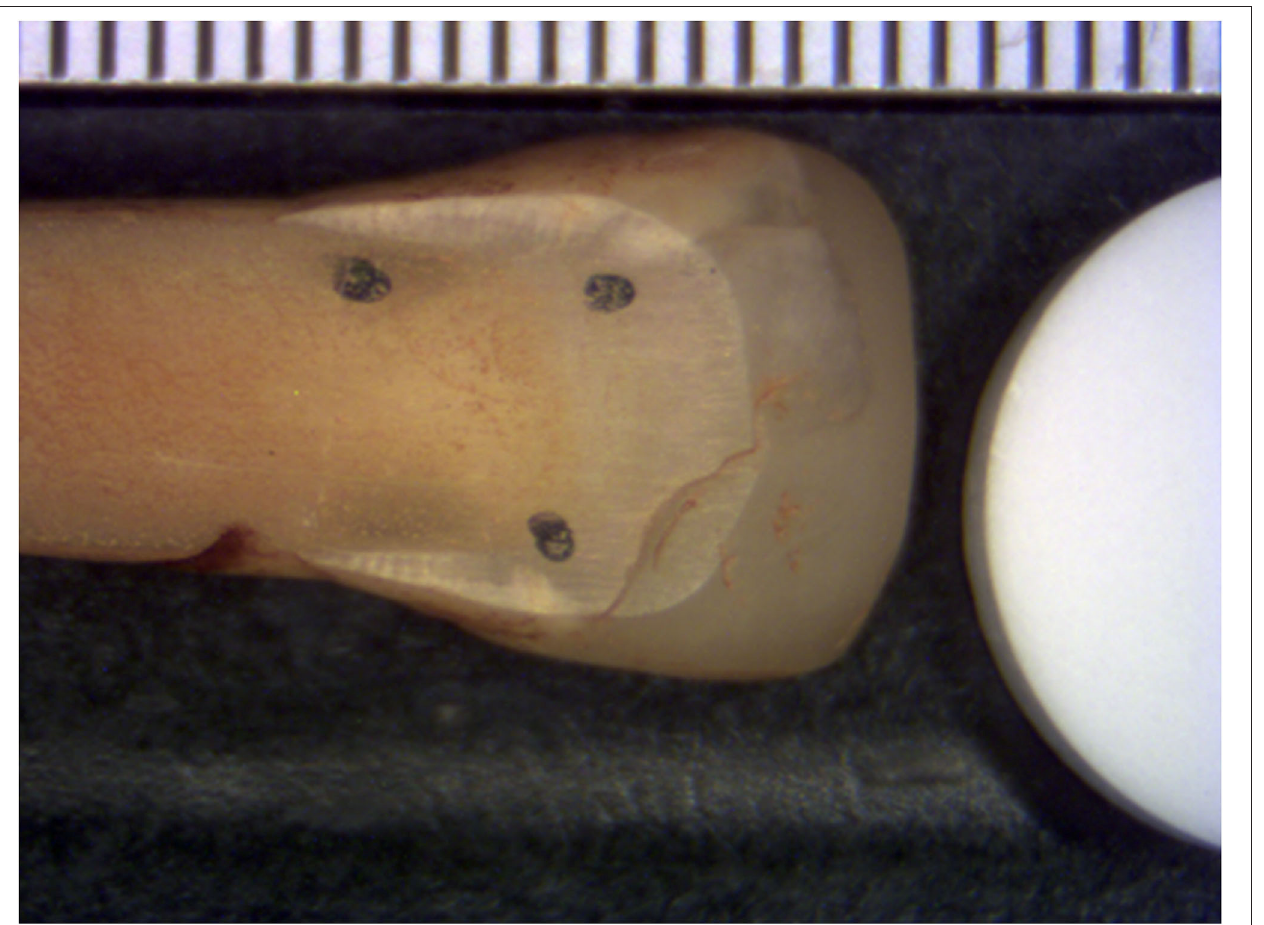
FIGURE 2 | An example of a tooth sample with the reference black and white areas needed for assessment of